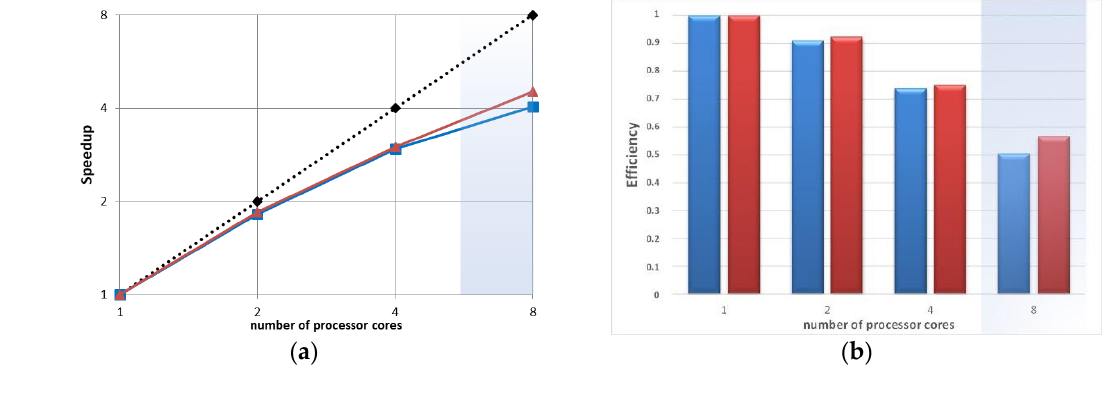
Figure 7. Experimental performance measured on platform A as a function of the number of engaged threads/cores ( 𝑁) , for both static (blue) and dynamic (red) scheduling strategies: ( a ) Speedup factor 𝑆(𝑁) (continuous lines) and ideal speedup (dashed line) shown as a reference; ( b ) efficiency 𝜀(𝑁) . Shaded areas in the graphs corresponds to the number of additional threads provided by the hyper-threading technology.